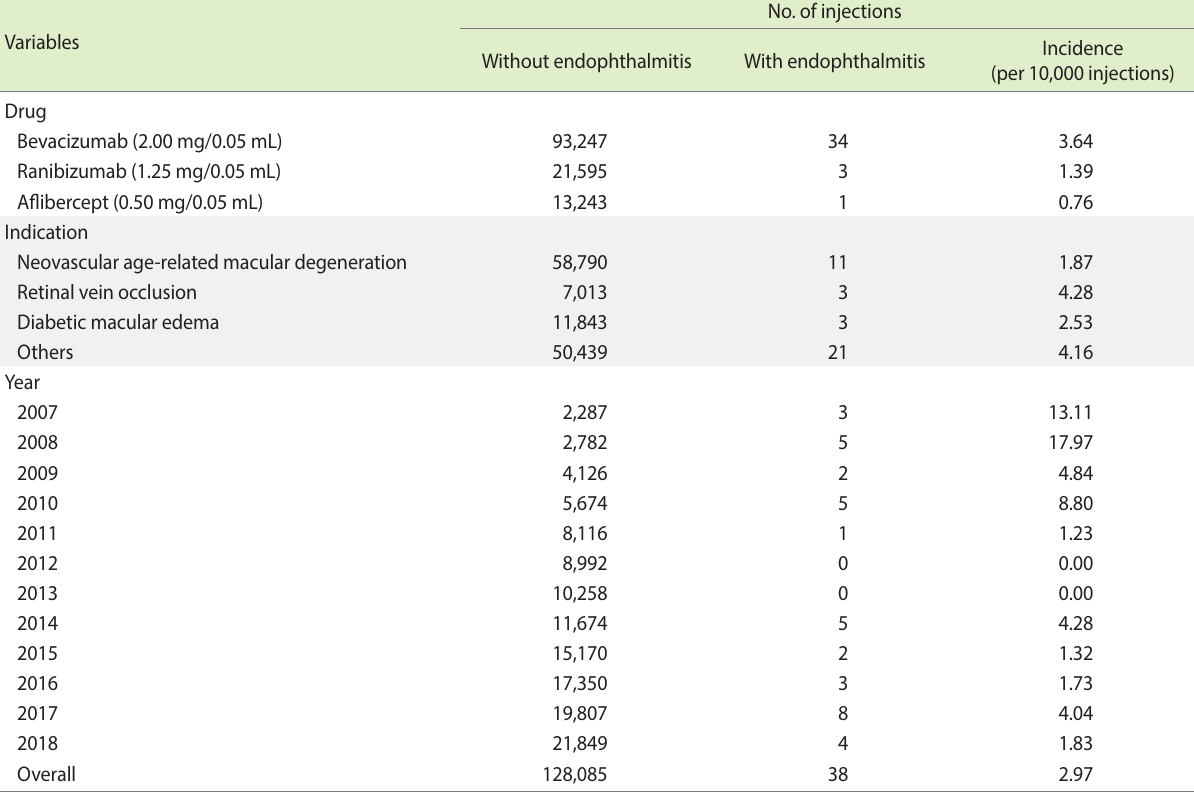
Table 3. Incidence of endophthalmitis after anti-vascular endothelial growth factor injections by drugs, indications, and year Variables